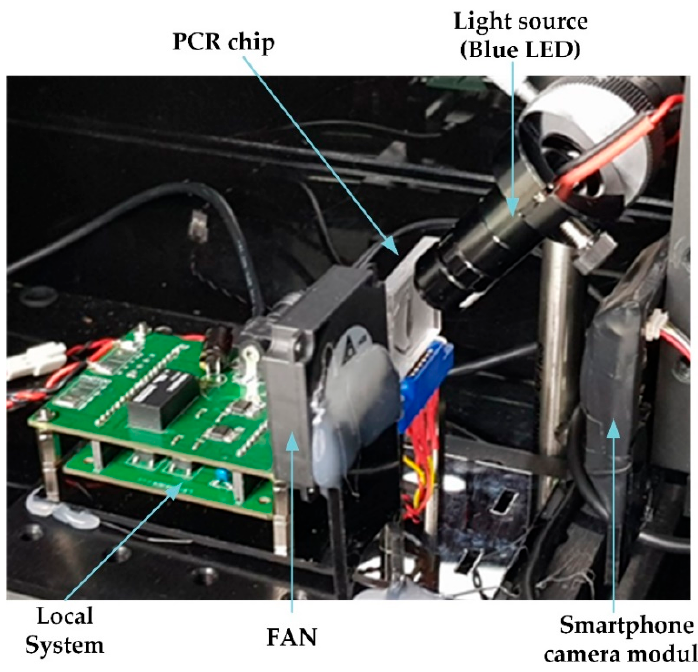
Figure 1. System setup of the proposed RT-PCR system.